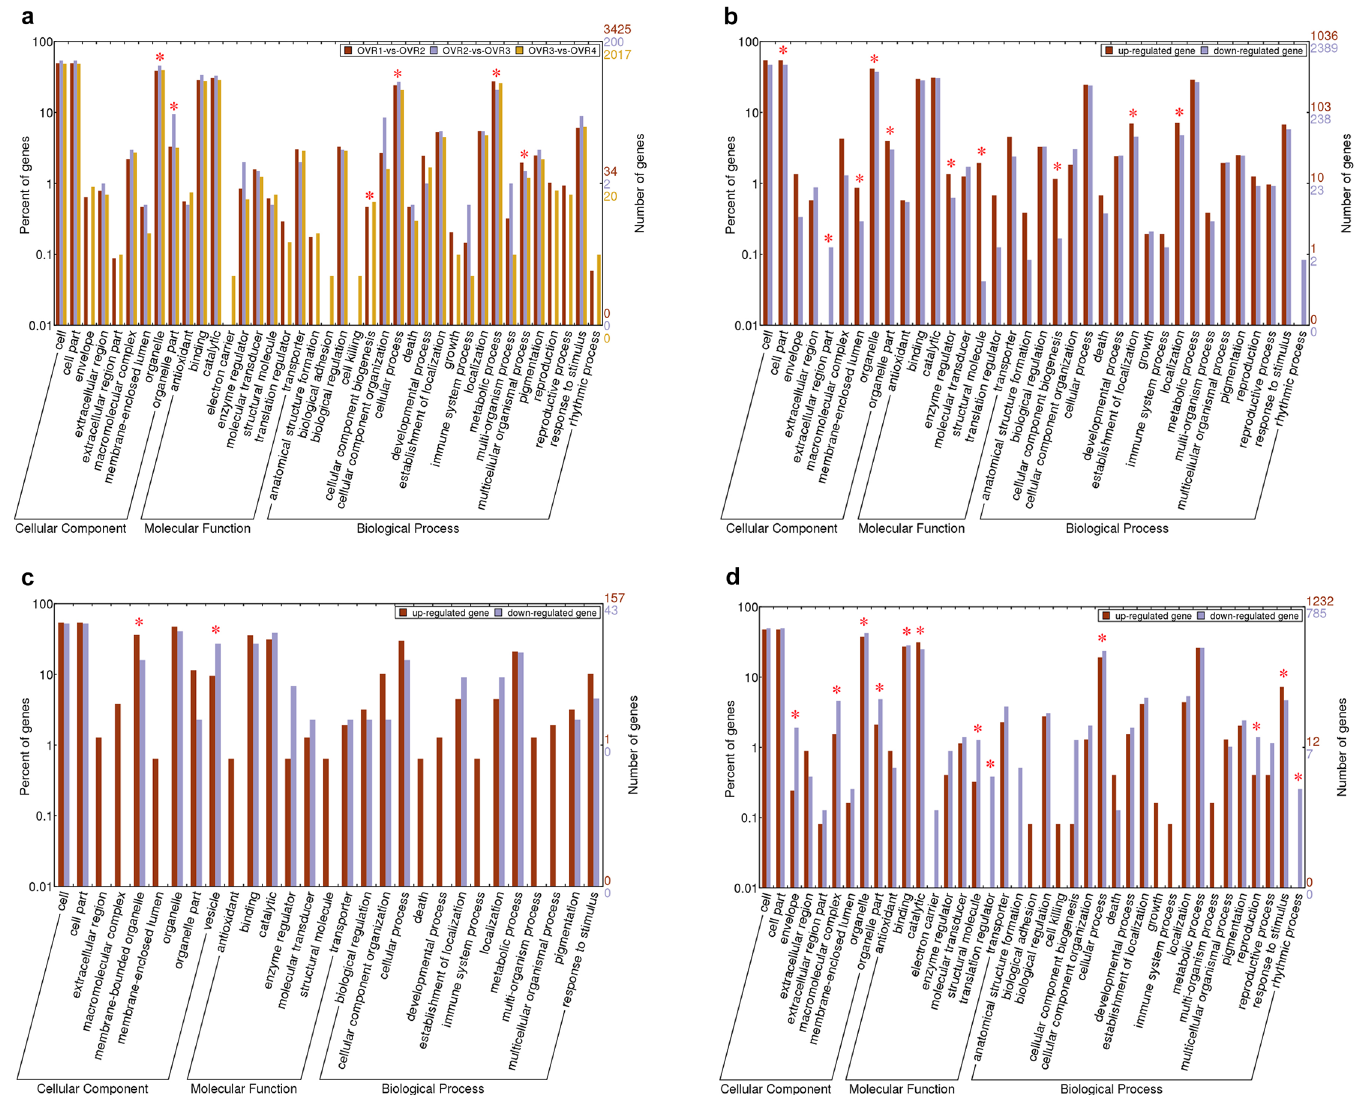
Fig 6. GO classification of DEGs among the adjacent development stages of ovule. a GO classification of all DEGs among the three comparisons (OVR1-vs-OVR2, OVR2-vs-OVR3 and OVR3-vs-OVR4). b GO classification of up- and down-regulated DEGs between OVR1 and OVR2. c GO classification of up- and down-regulated DEGs between OVR2 and OVR3. d GO classification of up- and down-regulated DEGs between OVR3 and